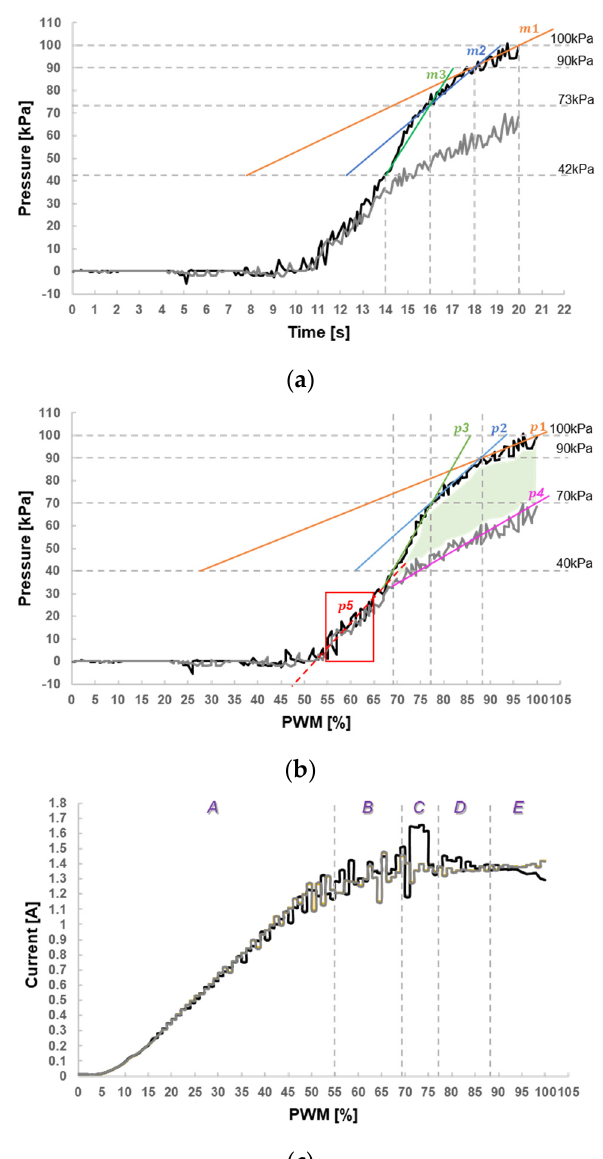
Figure 5. Numerical change of pressure sensor in the micro air pump operating process without PID control algorithm. ( a ) The cross plot of time and pressure sensor value, PWM duty ratio, ( b ) The cross plot of PWM duty ratio and pressure sensor value. ( c ) The cross plot of PWM duty ratio and current value.